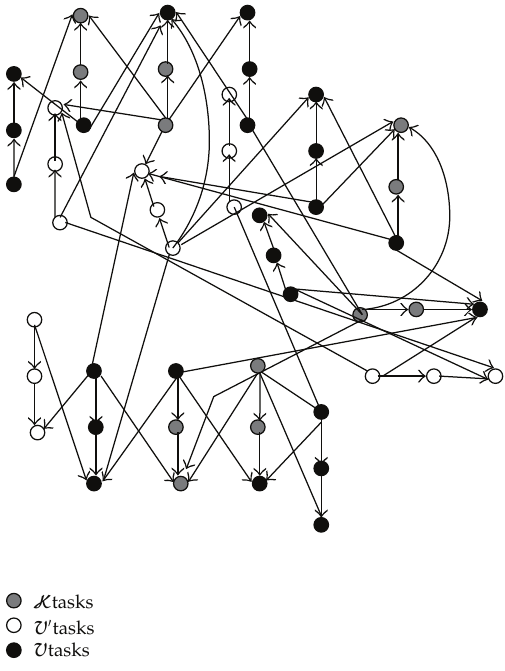
Figure 7: Partition of G ∗ graph into tasks sets V , K , and V